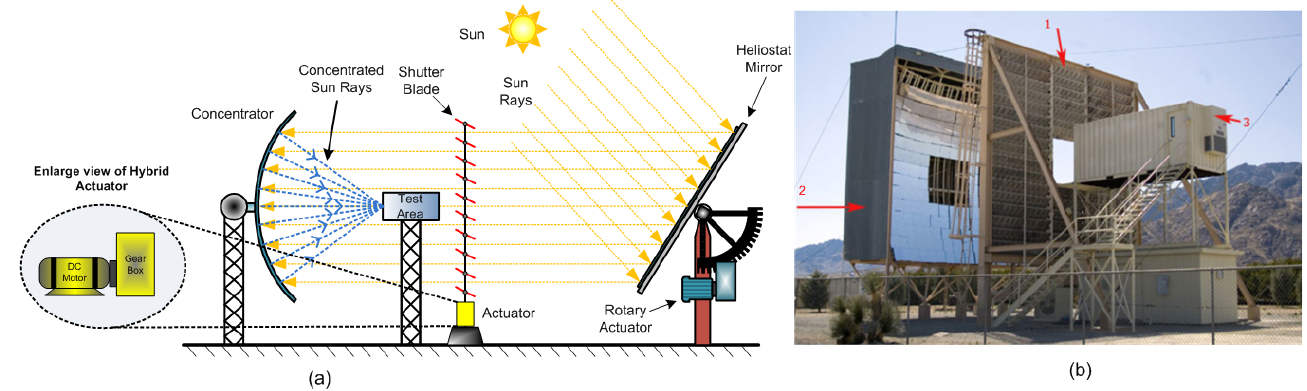
Figure 4. Rotary actuators functioning in solar furnace application ( a ) Schematic Diagram, ( b ) U.S. Army’s white sands solar furnace commissioned in 1972